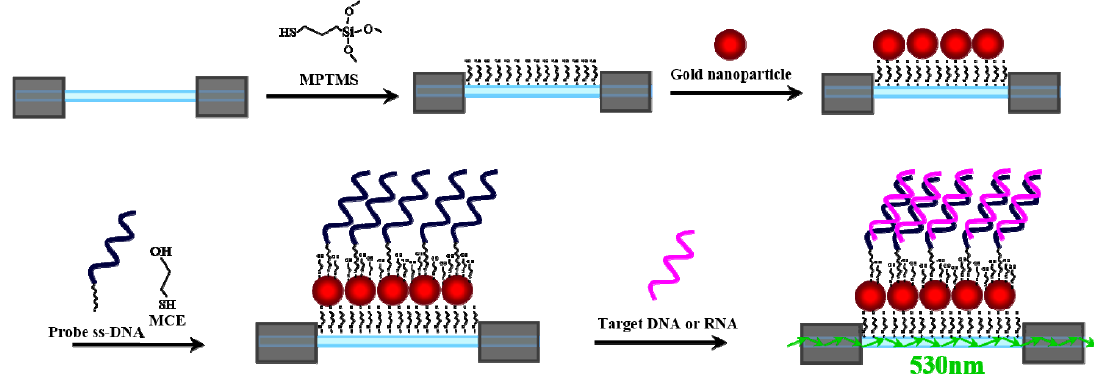
Figure 2. A schematic illustration of sensor layer construction: modification of MPTMS on fiber core surface, immobilization of AuNPs, bioconjugation of ssDNA probe, and hybridization of ssDNA probe with target ssDNA or ssRNA.